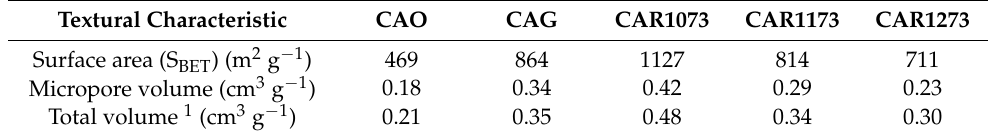
Table 4. Textural characteristics of activated carbons CAO, CAG, CAR1073, CAR1173, and CAR1273. Textural